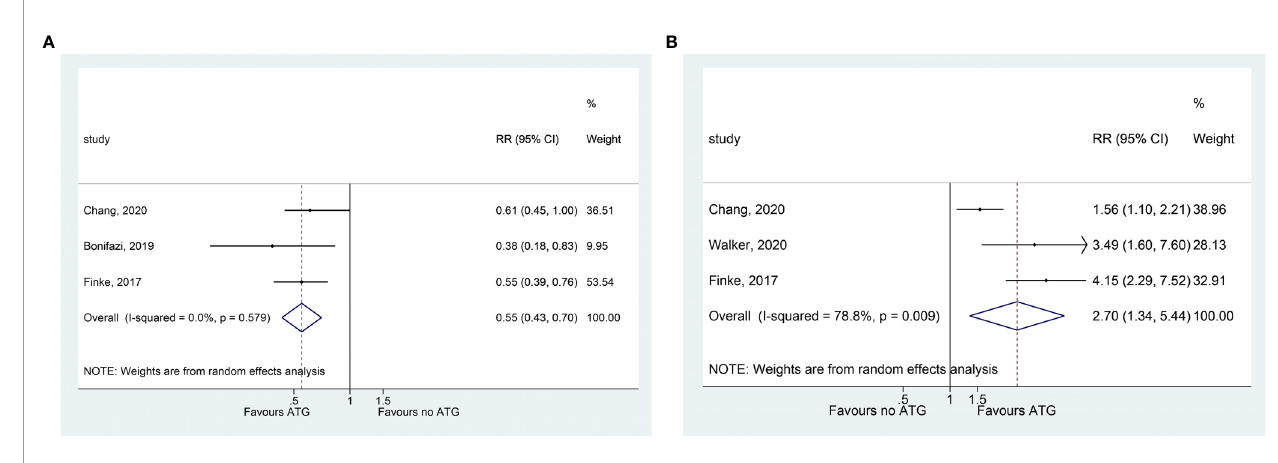
FIGURE 4 | Forest plot for GRFS (A) and free of immunosuppressant therapy (B) .